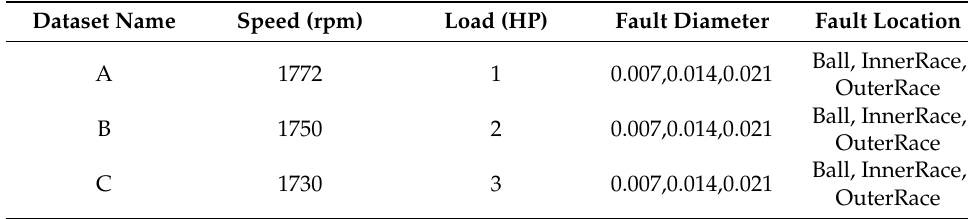
Table 2. Different load datasets of CWRU.